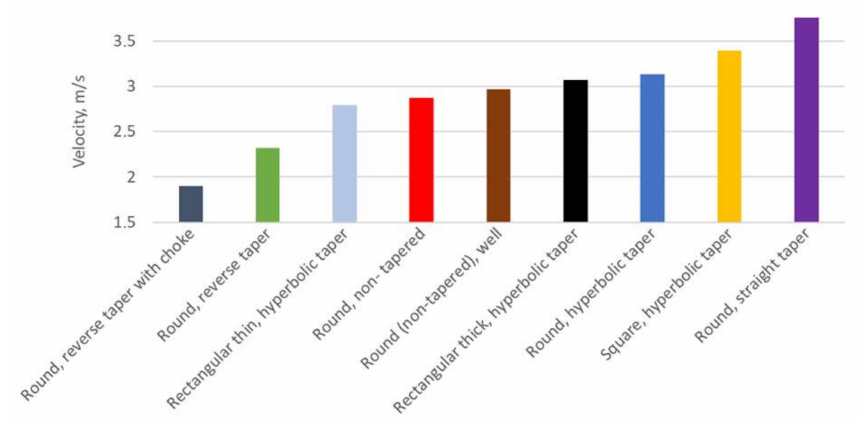
Figure 38. Average velocity criterion for examined 500 mm sprues,